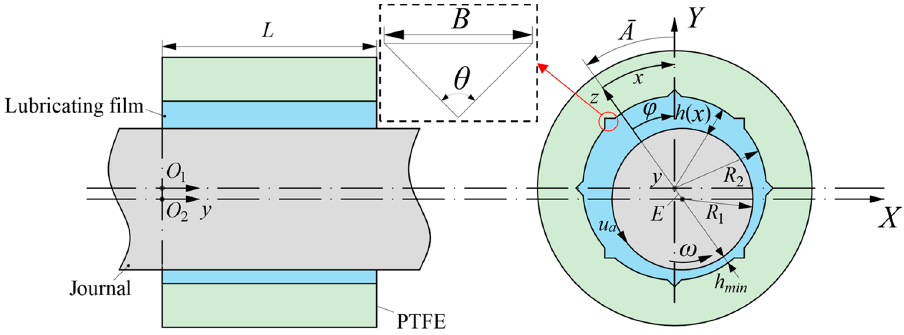
Figure 2. Nomenclature of water-lubricated hydrodynamic journal bearings. Table 1. Parameters of water-lubricated hydrodynamic journal bearings.